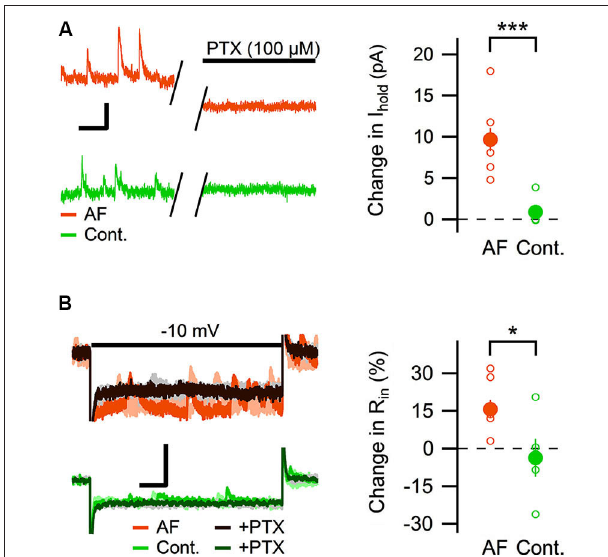
FIGURE 3 | AF-16 enhances tonic GABAergic transmission in CA1 stratum radiatum interneurons. (A) Diagram showing the effect of PTX on the holding current in CA1 stratum radiatum interneurons incubated in AF-16 ( n = 8) and control ( n = 5). Open circles represent the individual experiments while the filled circles represent the average ( ± s.e.m.) values. On the left are representative traces before and after application of PTX, scale bar represents 10 pA and 250 ms. (B) Diagram showing the effect of PTX on the input resistance in CA1 stratum radiatum interneurons incubated in AF-16 ( n = 8) and control ( n = 5). Open circles represent the individual experiments while the filled circles represent the average ( ± s.e.m.) values. On the left are representative traces during a − 10 mV test pulse before (orange/light orange and green/light green colors for AF and control, respectively) and after (dark brown/gray and dark green/gray colors for AF and control, respectively) application of PTX, scale bar represents 30 pA and 75 ms. * p < 0.05, *** p < 0.001.